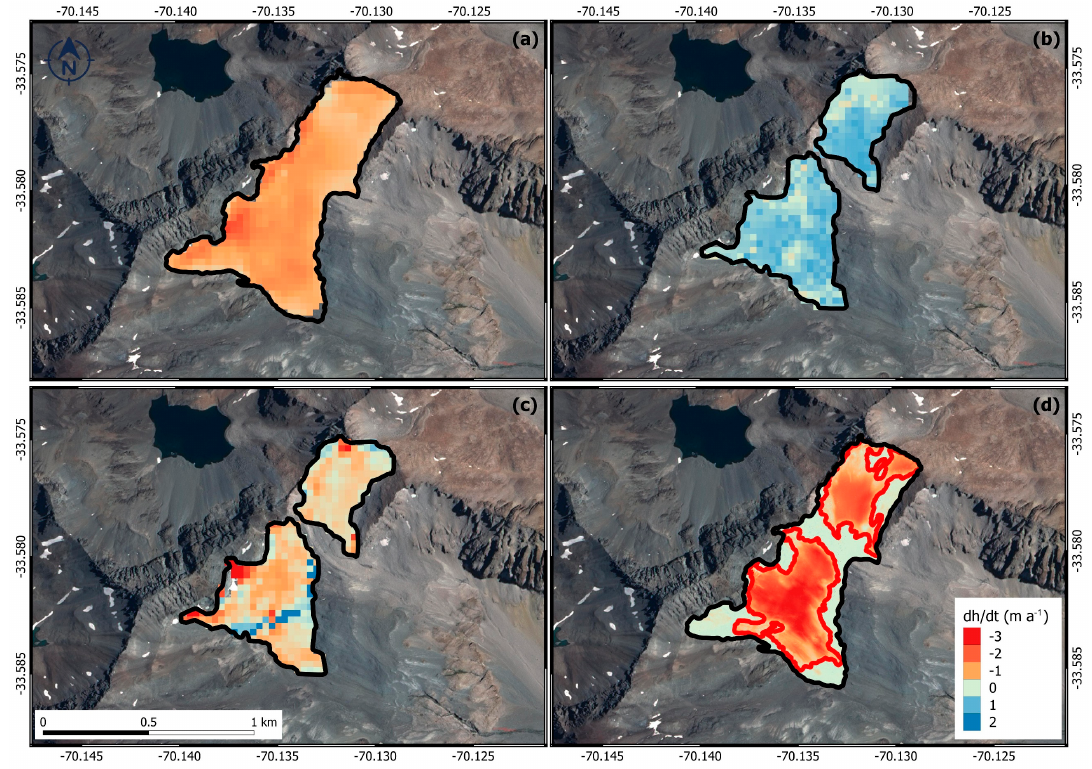
Figure 3. Glacier elevation change rate maps ( dh/dt ). ( a ) Elevation difference map for 1955 to 2000. ( b ) Elevation difference between 2000 and 2009. ( c ) Elevation difference map for 2000 to 2013. ( d ) Elevation differences between 2009 and 2015 (Black outline 1955 area, red outline 2009 area). Table 3. Summary of volume changes and geodetic mass balances for each observation period. We assumed an ice density of 850 kg m − 3